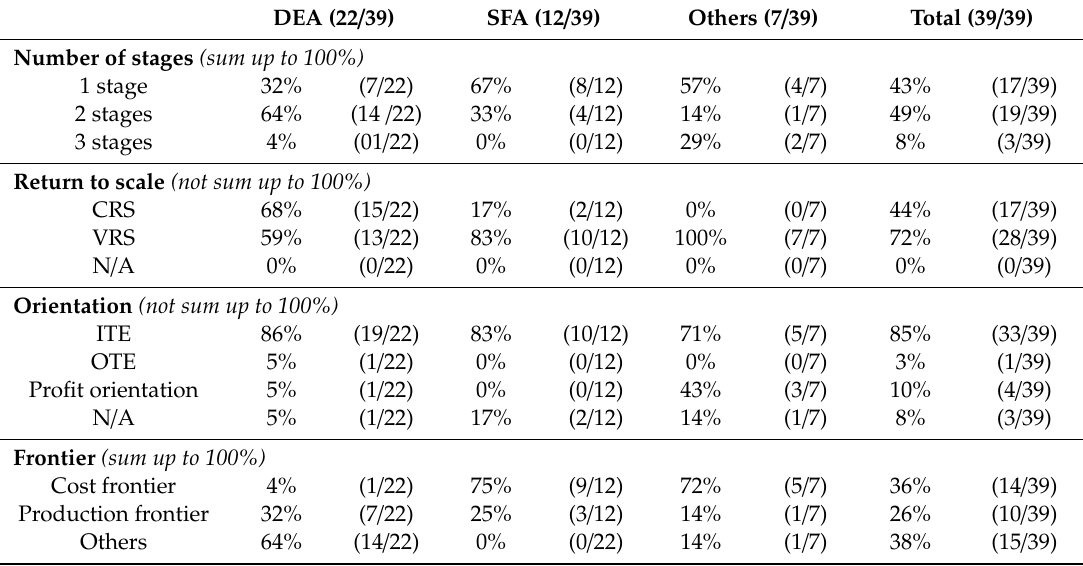
Table 1. Summary of methods used in included